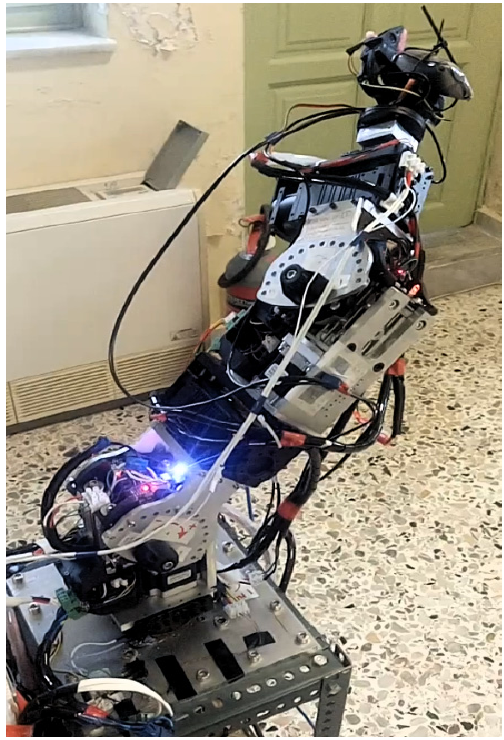
Figure 28. Optimal anatomy of the metamorphic manipulator derived under the MMA and MVR measure for Task 4.